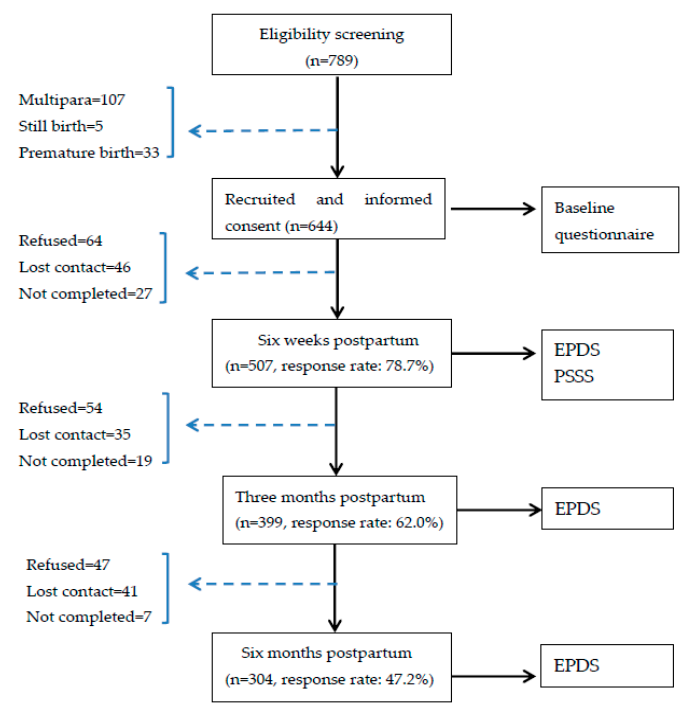
Figure 1. Flow of participants through the study. EPDS: Edinburgh Postnatal Depression Scale; PSSS: Postpartum Social Support Scale.